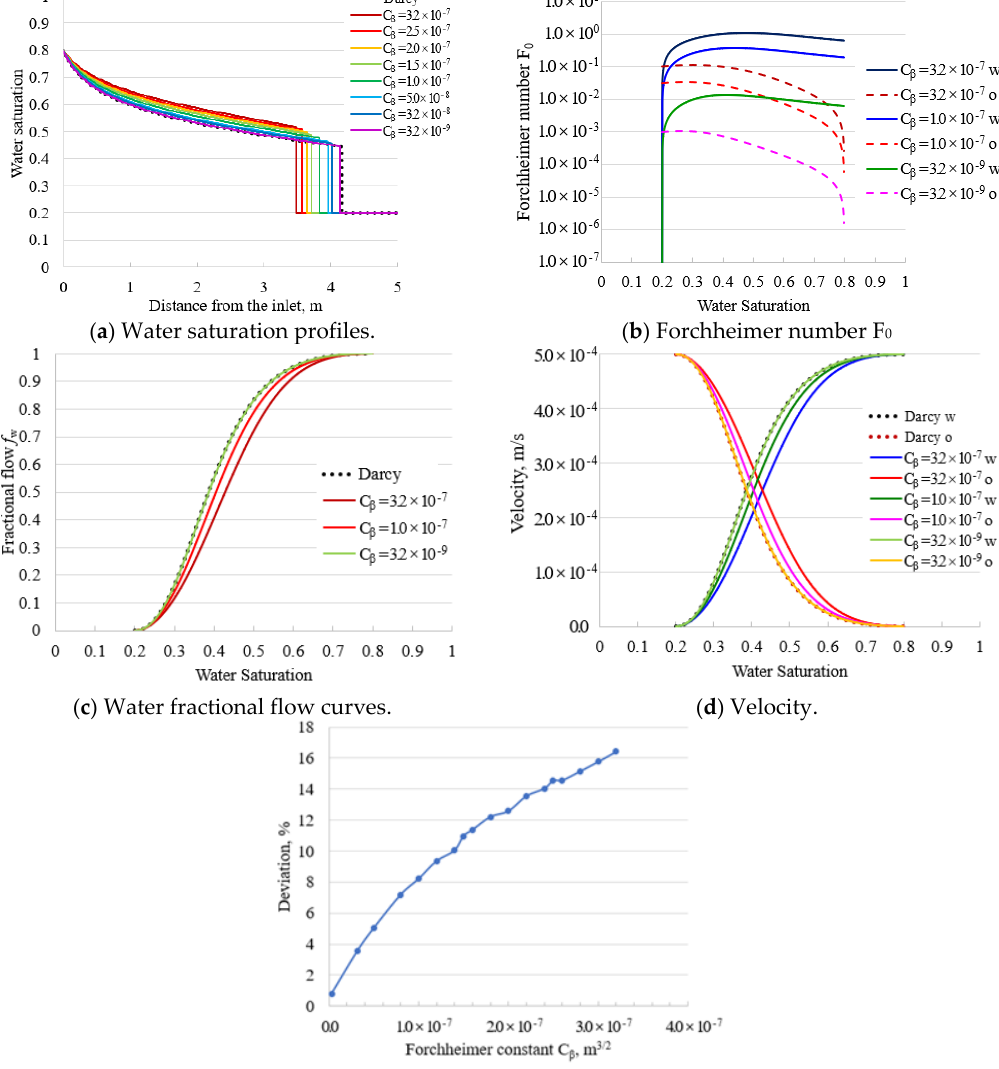
Figure 5. Comparison of Darcy equation versus Forchheimer equation with different C β values.